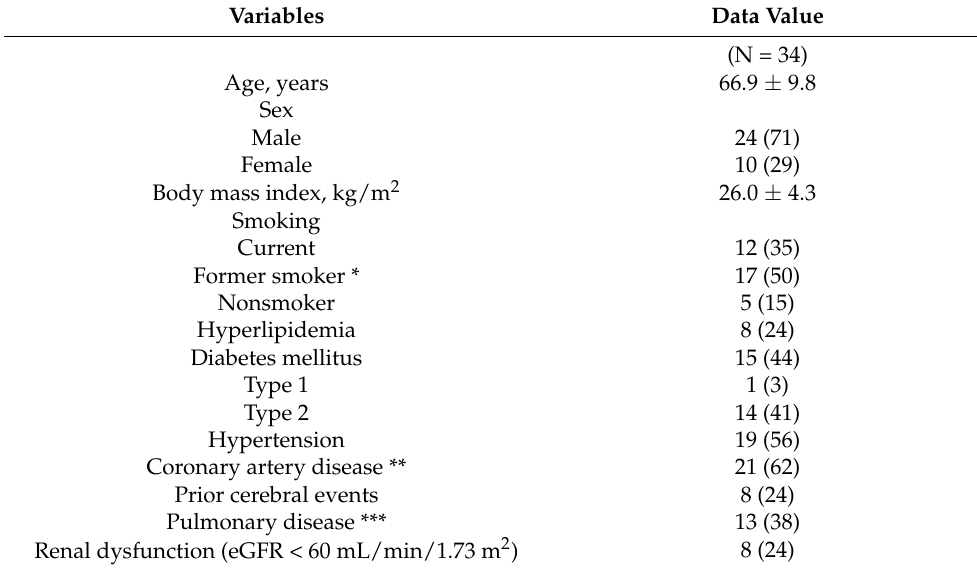
Table 1. Patient characteristics.